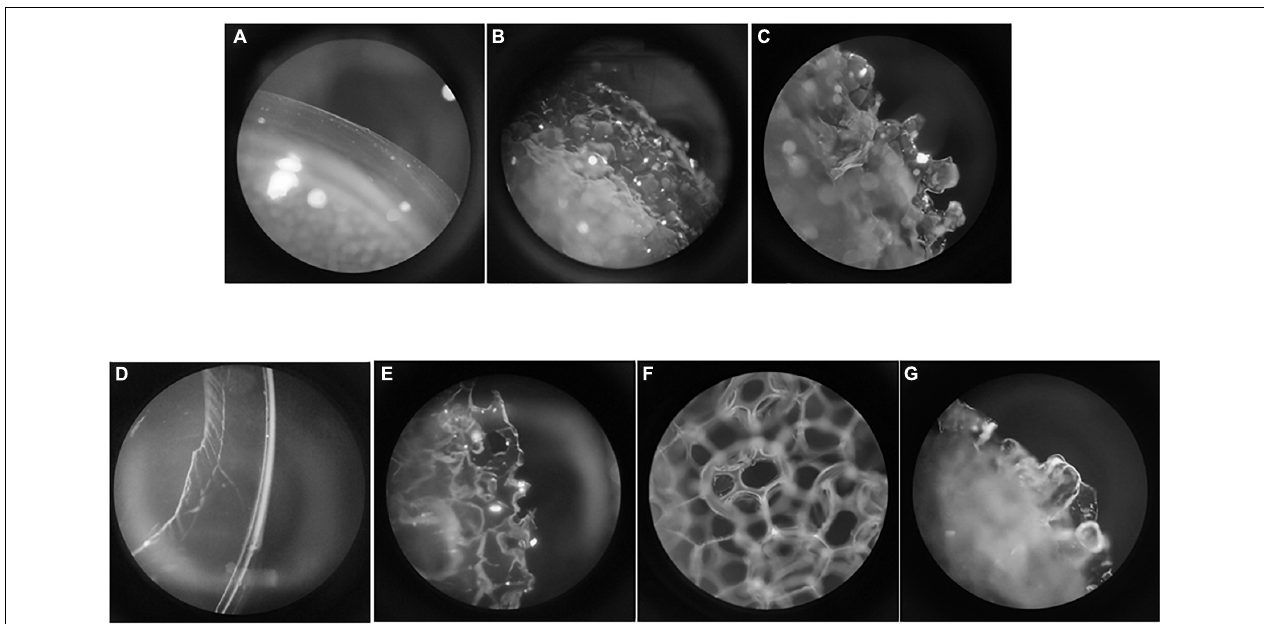
FIGURE 1 | Surface of each implant. (A) Mentor R (cid:13) smooth (10 µ m); (B) Mentor R (cid:13) SiltexTM (28 µ m); (C) Mentor R (cid:13) CPGTM (36 µ m); (D) Polytech R (cid:13) PolysmoothTM